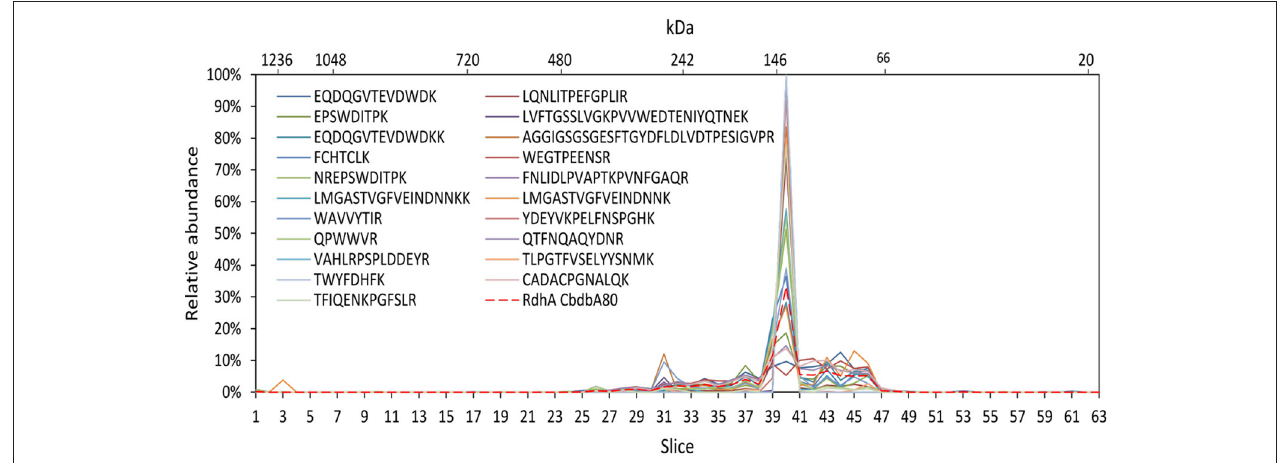
FIGURE 5 | Analysis of single peptide distributions across the blue native gel lane. Relative distribution of RdhA CbdbA80 across the gel lane (red dashed line) together with the distribution of all single detected peptides of RdhA CbdbA80 after protein extraction according to mode 3. The peptide maxima are all in slice